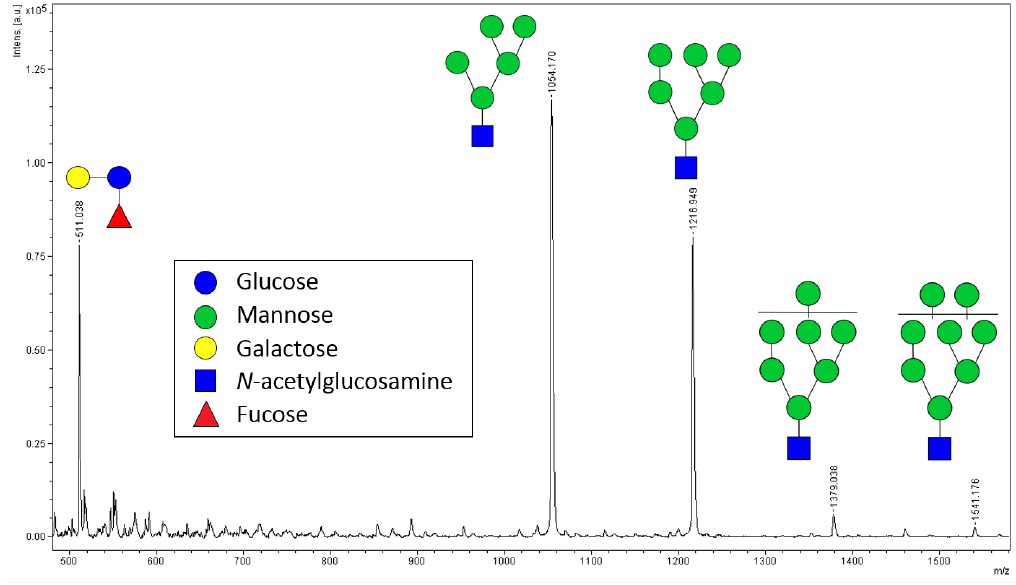
Figure 2. MALDI-ToF mass spectrum for 3-FL ( m/z 511)-spiked N -glycans released from RNase B using Endo BI-1.